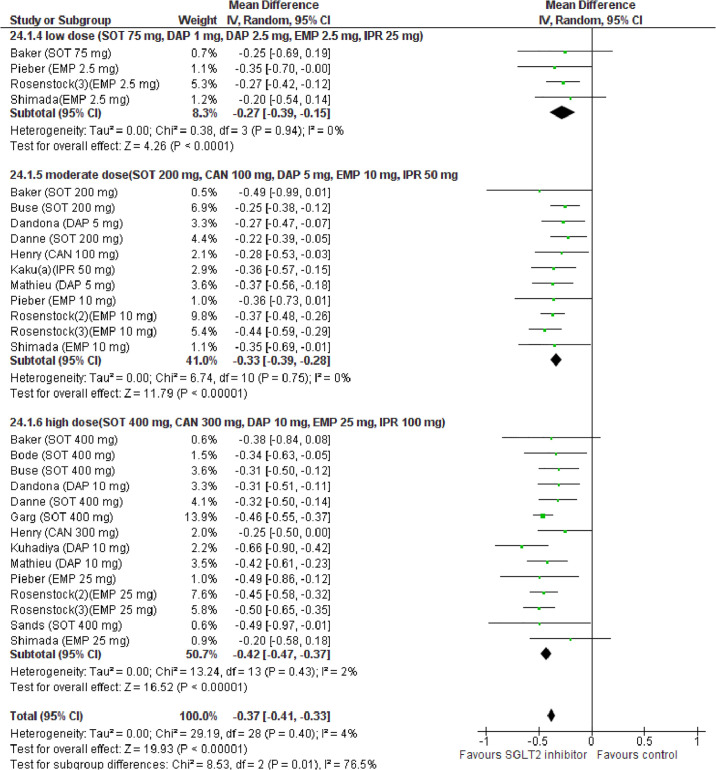
Forest plot of comparison: SGLT2 inhibitors, outcome: HbA1c change (%).